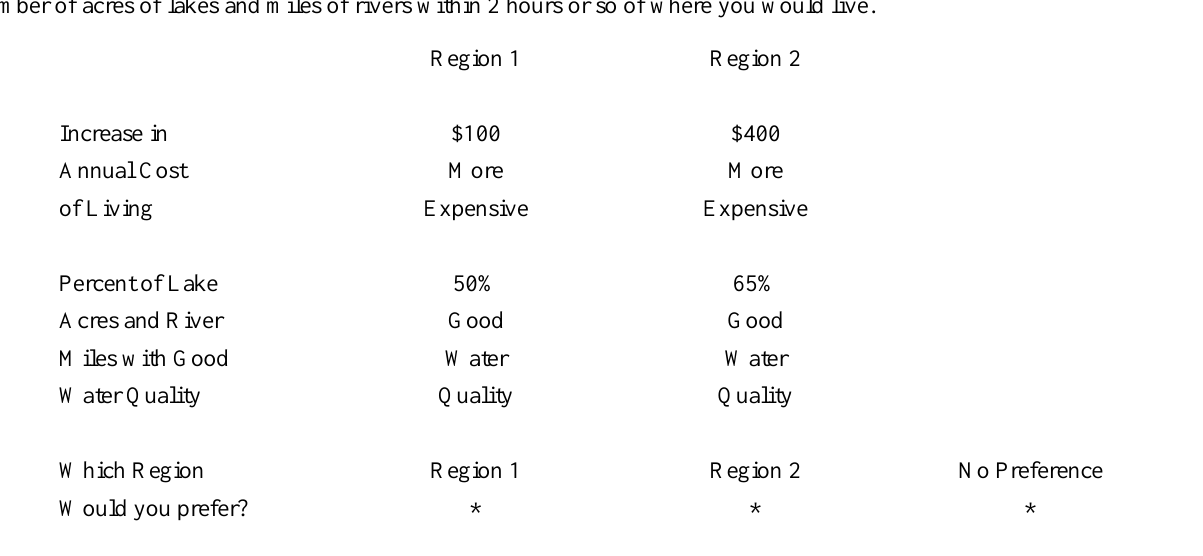
Figure 2. Text of water quality survey